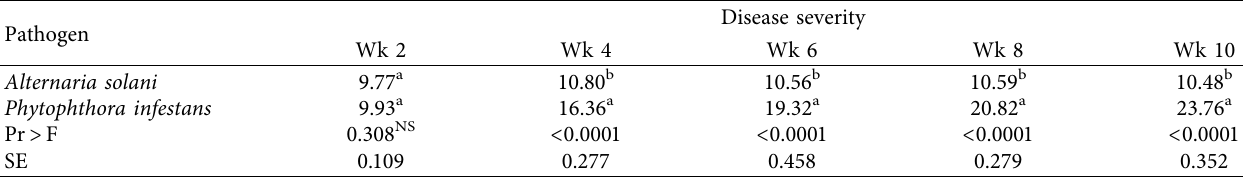
Table 1: Influence of the test pathogen on disease severity.